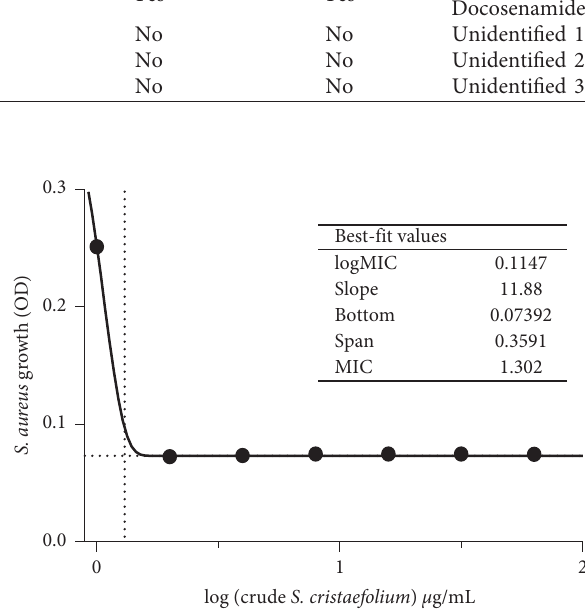
Figure 2: MIC graph of S. cristaefolium against extract S. aureus using the Gompertz equation. The antibacterial activity of S cris- taefolium extract was determined by the broth microdilution method, with three independent replications. The MIC of its crude extract against S. aureus was 1.302 µ g/ml. DMSO as a control negative has MIC > 500 µ